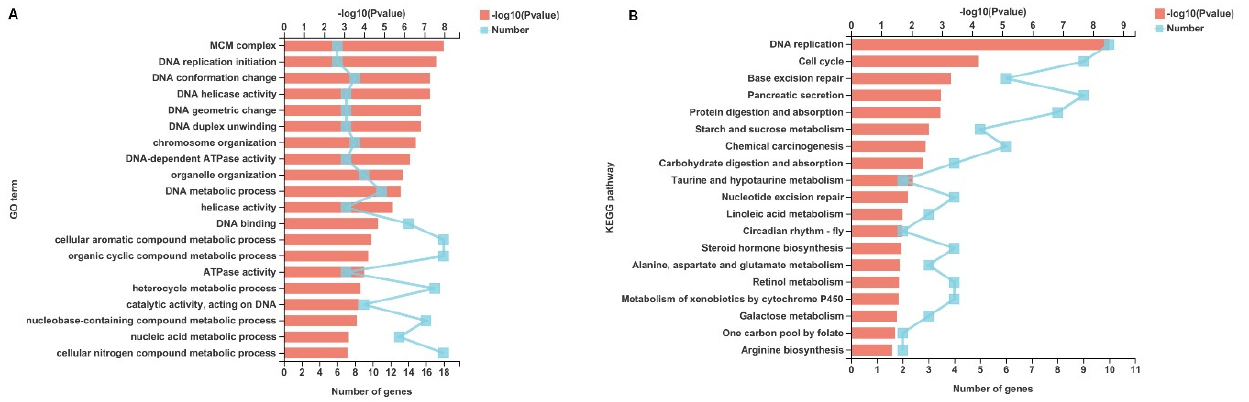
Figure 4. GO and KEGG pathway enrichment analysis of the identified DEGs. ( A ) Top20 of GO term enrichment. ( B ) Top20 of KEGG pathway enrichment. The y − axis indicates the GO term or KEGG pathway. The bottom x − axis indicates the number of DEGs in each GO term or KEGG pathway. The upper x − axis represents the significance level of